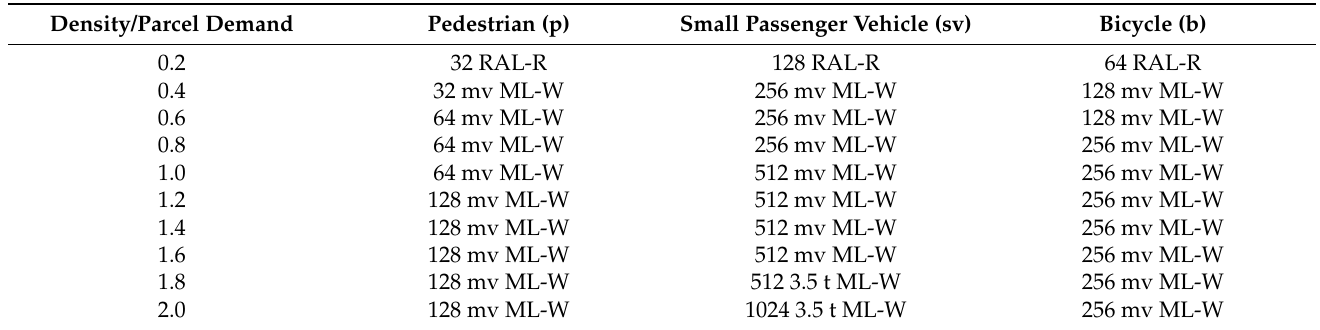
Table 2. The best combination of the number of CDPs and delivery concepts for each density for each customer’s mode